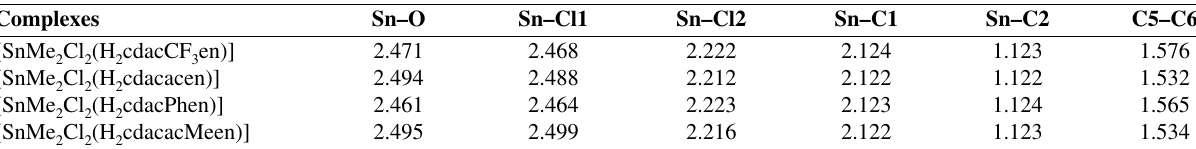
Table 7 . The selected bond lengths (Å) of Sn(IV) complexes (labels for atoms can be found in Figures 3 and S1) Complexes